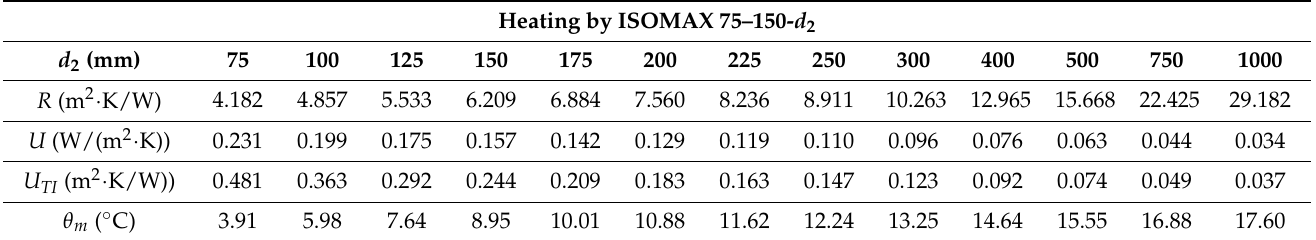
Table 1. Results of calculation of physical variables during the heating season.